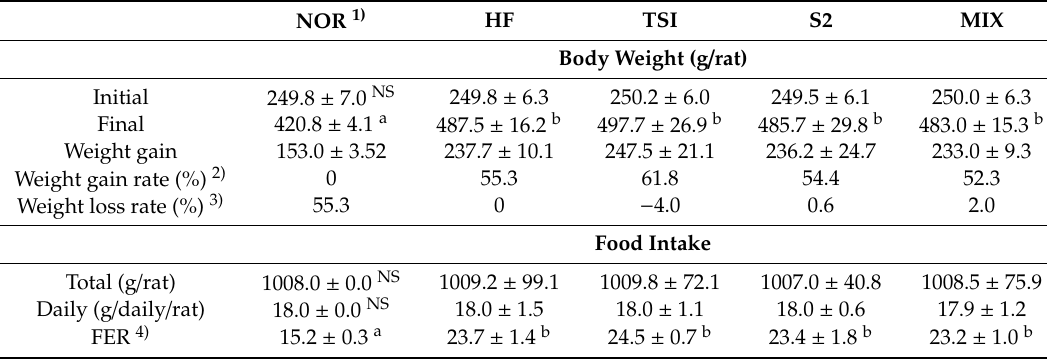
Table 6. Body weight changes, food intakes, and food e ffi ciency ratio of Sprague-Dawley (SD) rats during the experimental period ( n =